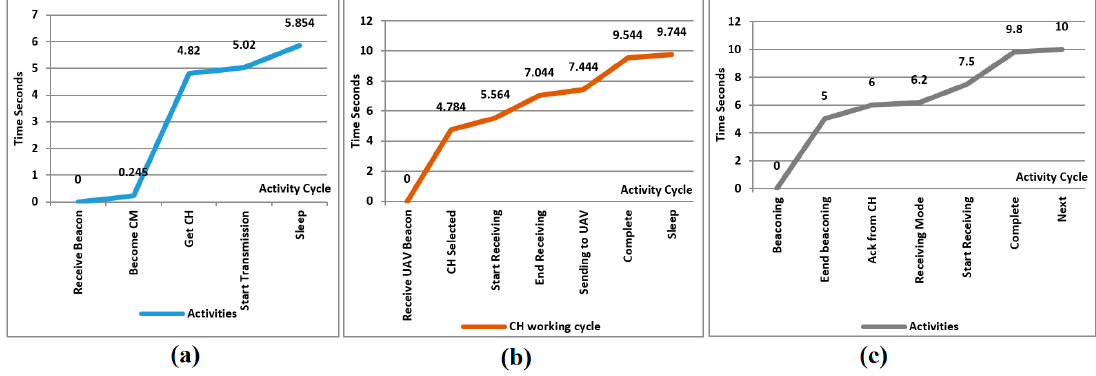
Figure 15. Activities of proof of concept devices related to time ( a ) sensor node ( b ) cluster head ( c ) UAV.